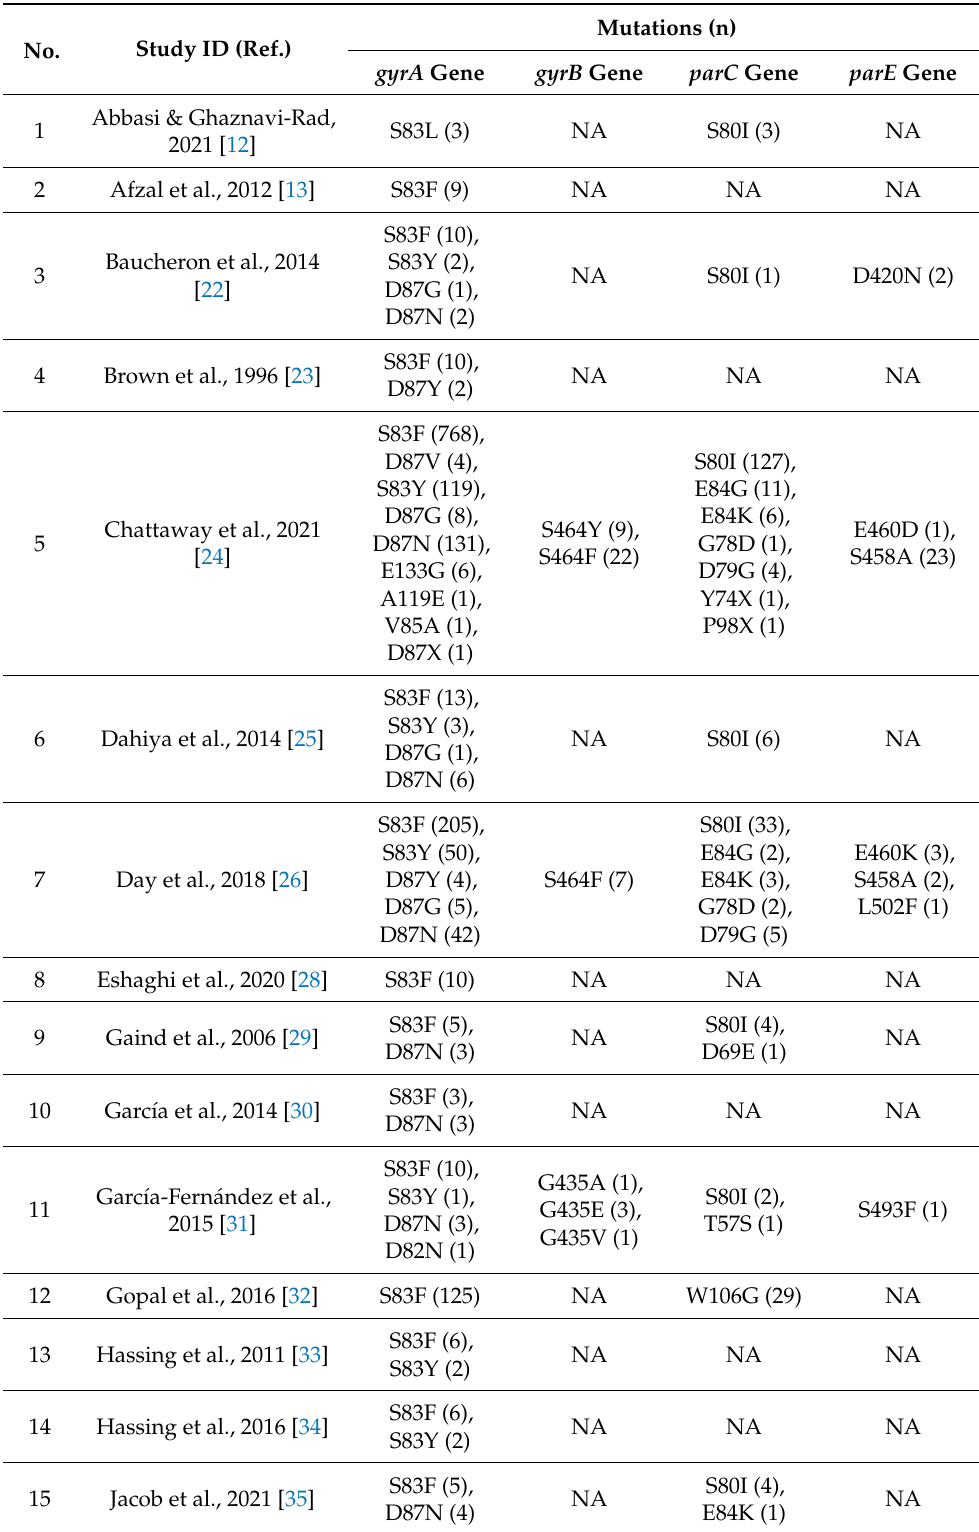
Table A2. Distribution of mutations in gyrA , gyrB , parC and parE